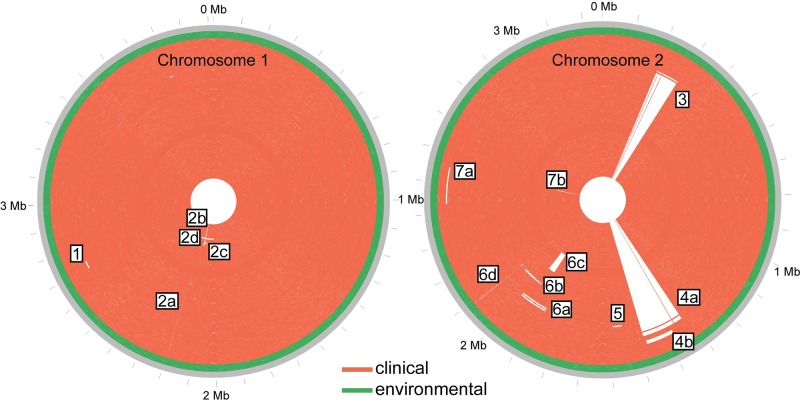
The location of large deletions in P314 genomes relative to MSHR1435.Whole genome sequencing of 120 B. pseudomallei collected over 17 years reveals large chromosomal deletions across both chromosomes. The genomes’ order from the outside to inside concentric circles corresponds to the top to bottom order on the phylogenetic tree (Fig 3). This inside-to-out arrangement approximates the evolutionary trajectory of the infecting B. pseudomallei population. MSHR1435, which is used as the reference, is outermost and is a closed genome while all others are high quality drafts. All environmental isolate genomes (including MSHR1435) are basal in the phylogeny (Fig 3) and found in the outermost rings (green) of the concentric circles. Raw sequence reads were mapped to the reference chromosomes and any base with a depth of coverage of <25% of the average genome coverage was considered to be missing. The figure was constructed with Circos [43]. Coordinates for deleted regions are as follows: 1(2700183–2733804), 2a (2196965–2198380), 2b (2141162–2157867), 2c (2106537–2157867), 2d (2006273–2214755), 3 (204194–294524), 4a (1322983–1479924), 4b (1375399–1474558), 5 (1551804–1588830), 6a (1874062–1994243), 6b (1934891–1974776), 6c (1956279–2122568), 6d (2069785–2099797), 7a (2429295–2552683), 7b (2546831–2555624).